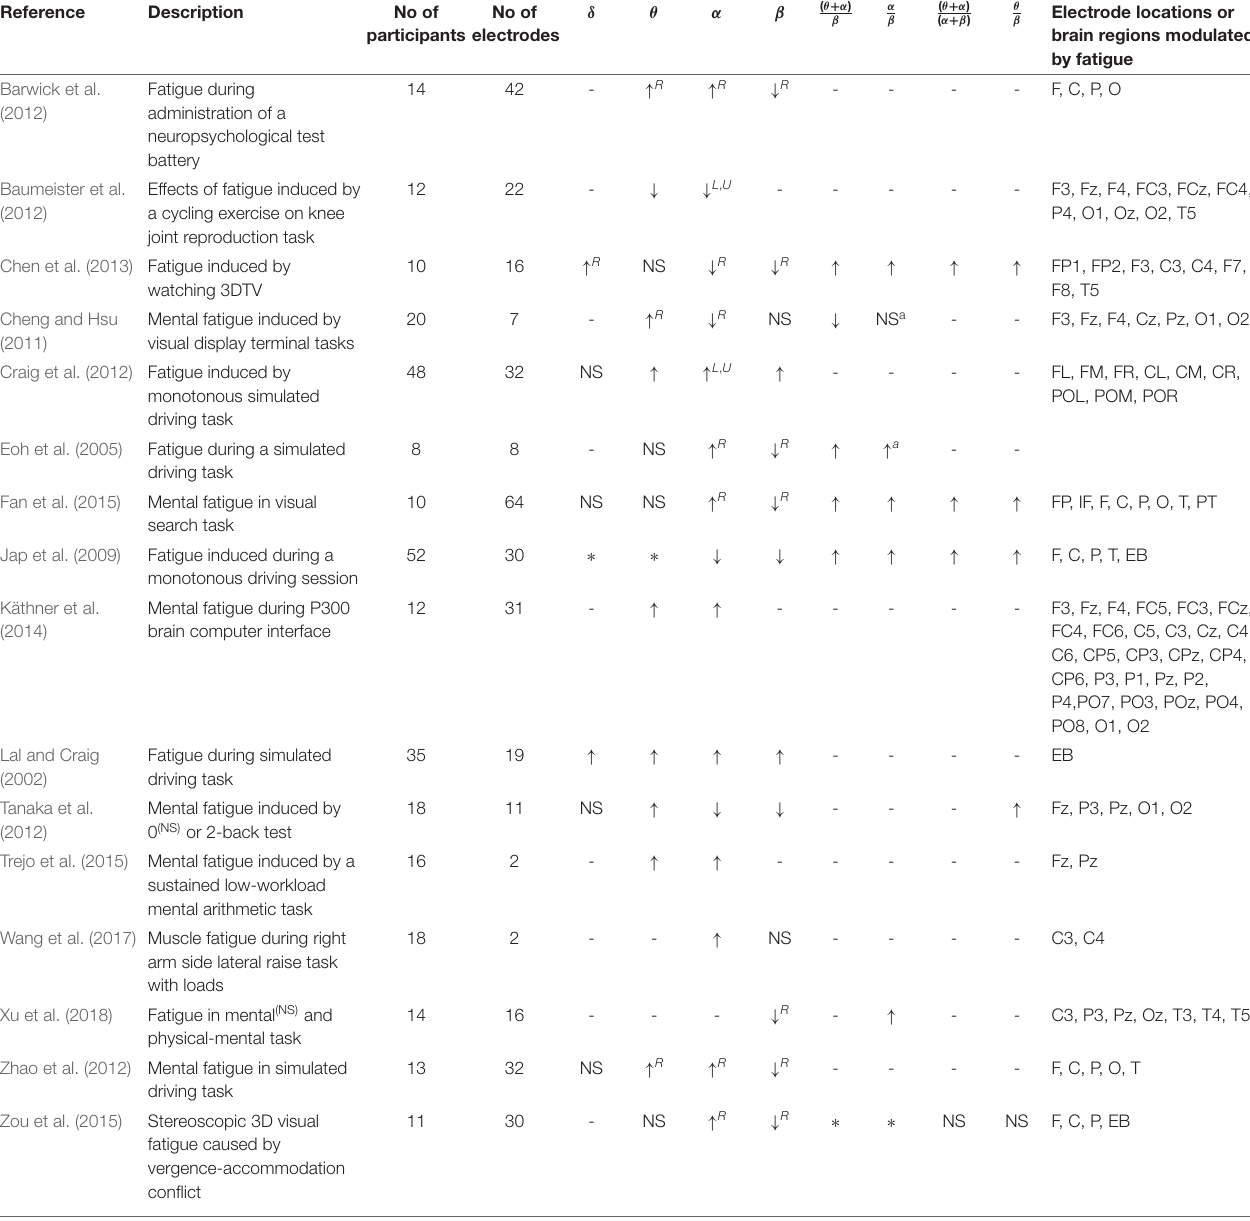
TABLE 1 | Literature summary on modulations in the EEG spectral features with fatigue.